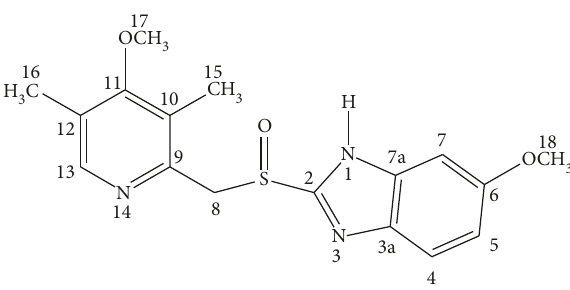
Figure 4: OMP with numbered carbon and nitrogen